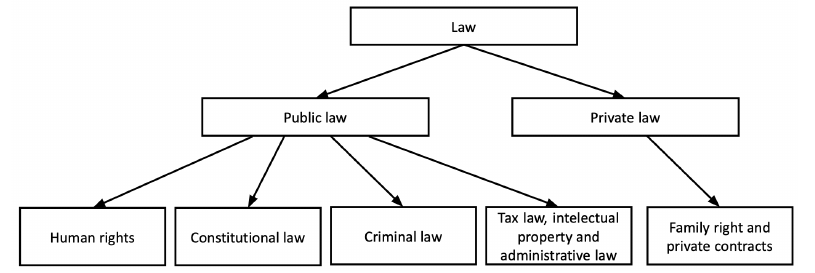
Figure 1. Survey classification by types of